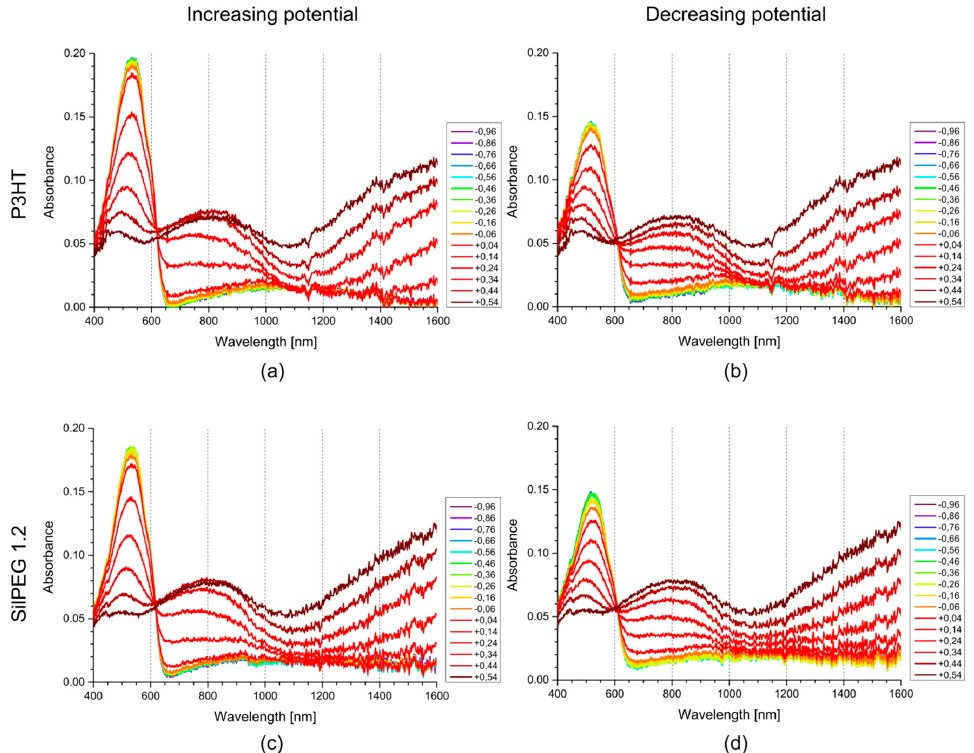
Figure 4. UV-Vis-NIR spectra recorded during the application of stepwise increasing (left) and decreasing (right) potential (vs. Ag/Ag+) to films of the investigated polymer and copolymer: ( a , b ) regioregular P3HT; ( c , d ) SilPEG1.2 deposited on ITO/quartz electrodes.